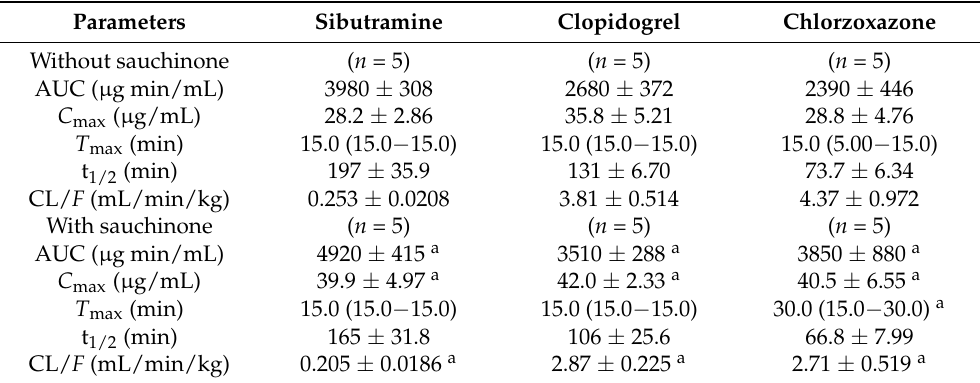
AUC, area under the plasma concentration–time curve from time zero to the last measured time to infinity; C max , peak plasma concentration; T max , time to reach C max ; t 1/2 , terminal half-life; CL/ F , clearance/absolute bioavailability.; a Significantly different ( p < 0.05) compared with that without sauchinone.